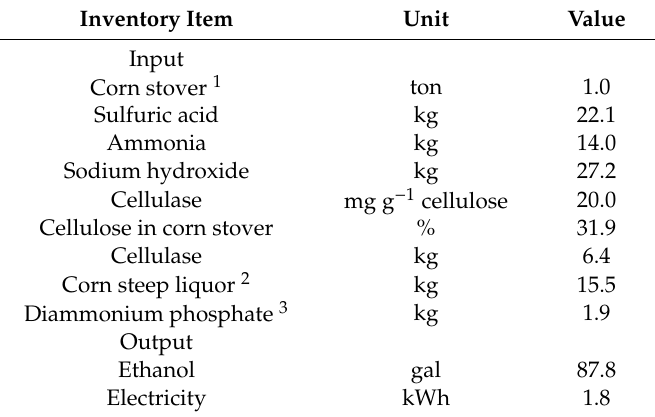
Table 4. Key technological data per ton of corn stover for ethanol